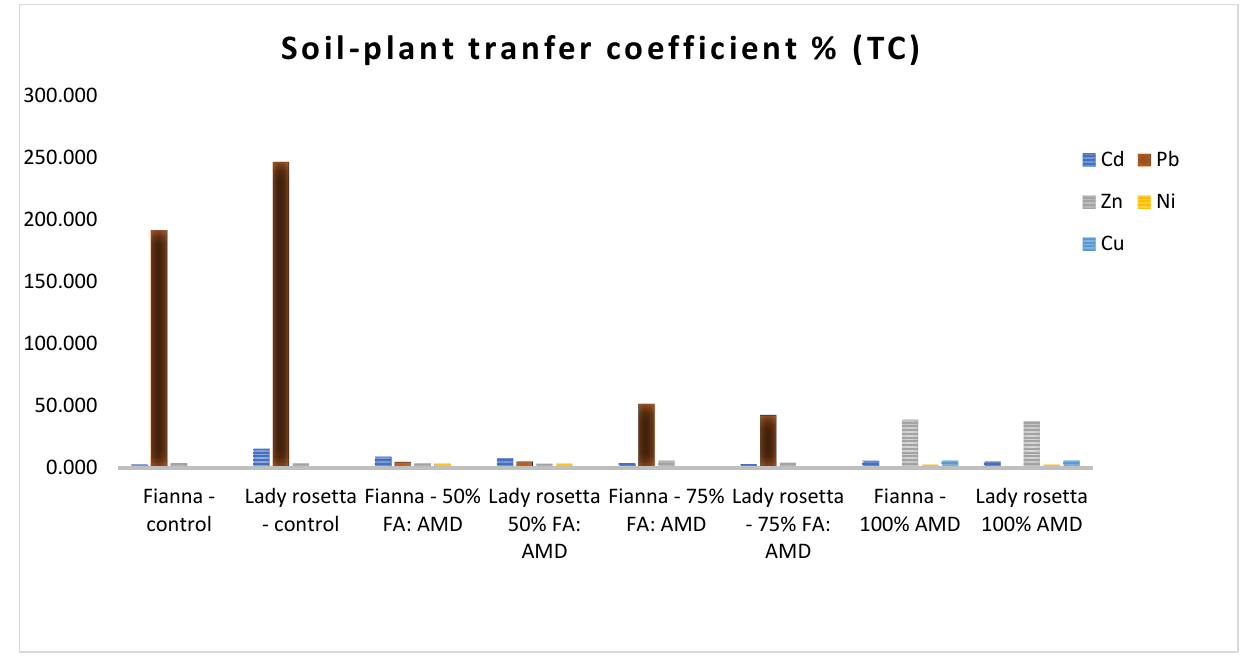
Figure 4. Soil-Plant Transfer Coefficient % (TC) of Fianna and Lady rosetta cultivar irrigated with acid mine drainage water. Values (Mean ± S.E).